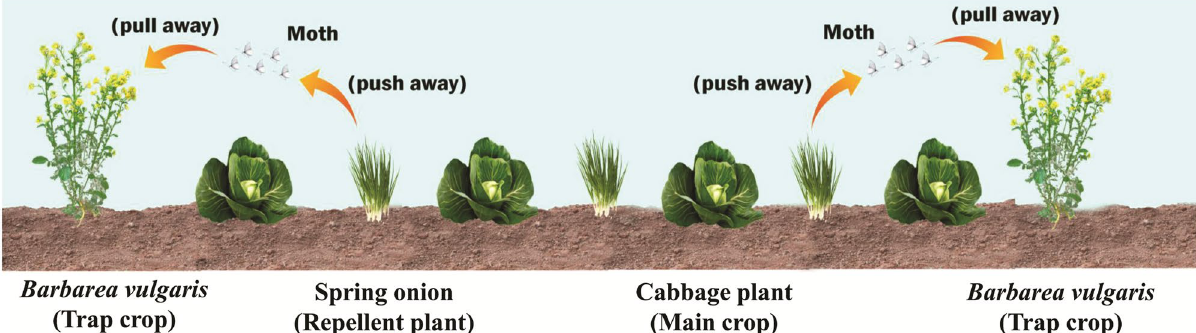
Figure 1. A schematic representation of the management of cabbage moth by using repellent "push" plant and trap "pull" plant. When Cabbage (maincrop) is planted with spring onion (repellent) non-host intercrop plant and simultaneously with attractive B. vulgaris, Yellow rocket cress (trap plant) as a barrier plant, it reduces the infestation of cabbage by cabbage moth. This occurred by repelling away the cabbage moth, that were trying to feed on the cabbage, from the push plant using stimuli that alter the host fragrance and at the same time pull away by the trap plant using highly attractive